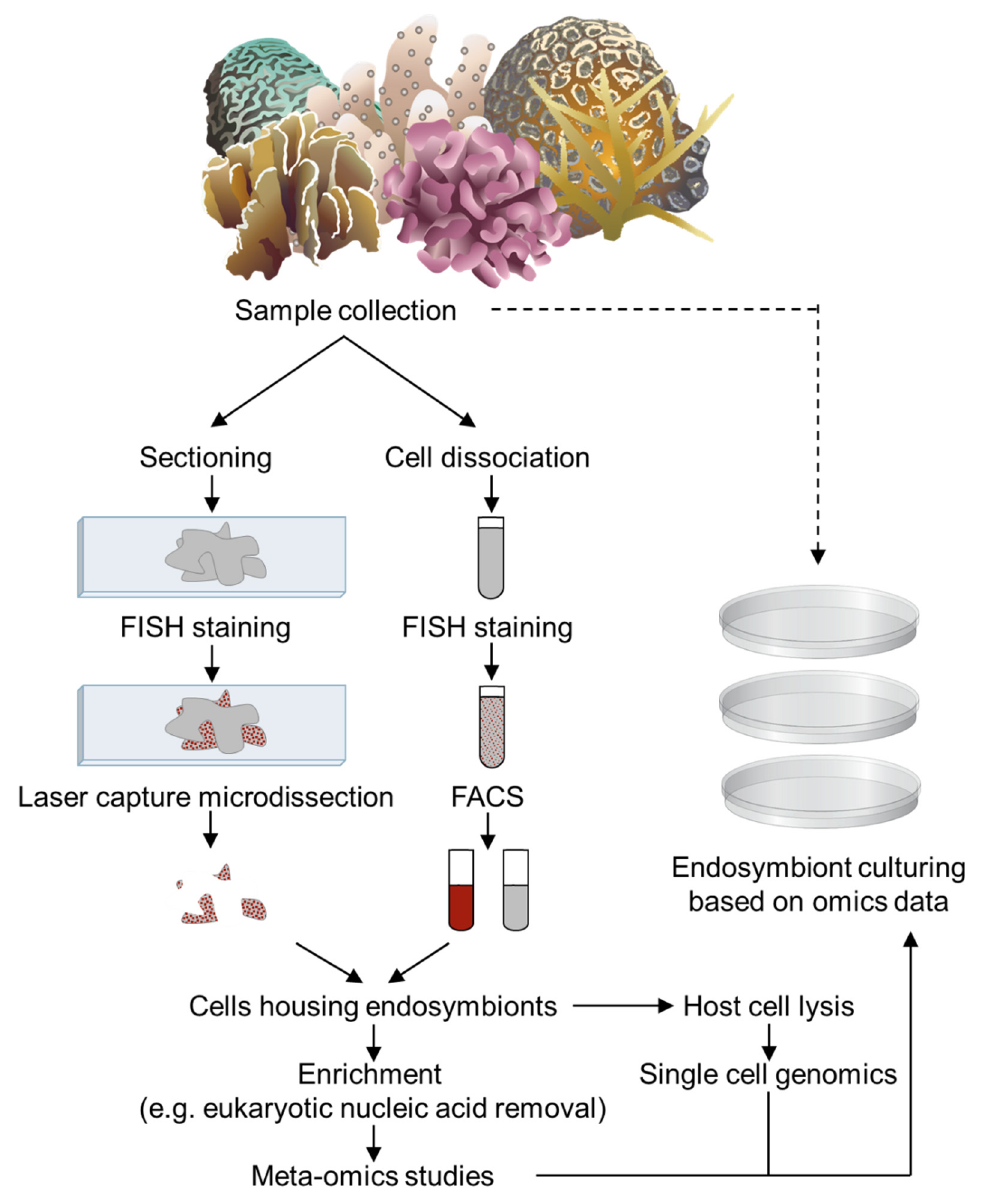
Figure 3. Proposed workflow for meta-omics studies of coral-associated endosymbionts. To optimize meta-omics studies in coral endosymbionts, we recommend the use of techniques allowing for the selection of cells harboring endosymbionts. FISH can be used on tissue sections to highlight endosymbionts, and LCM can allow for the capture of cells harboring them (left). Alternatively, coral cells can be dissociated, stained by FISH, and sorted through FACS (middle) [166]. This would maximize the abundance of bacterial reads in subsequent meta-omics studies. These symbiont-housing coral cells can then be lysed to release intracellular bacteria that can be sorted and individually sequenced through single cell genomics. Furthermore, omics data would give insight into the conditions needed for the culture of coral endosymbionts (right). Coral and plate images courtesy of the Integration and Application Network (ian.umces.edu/symbols/, accessed on 26 May